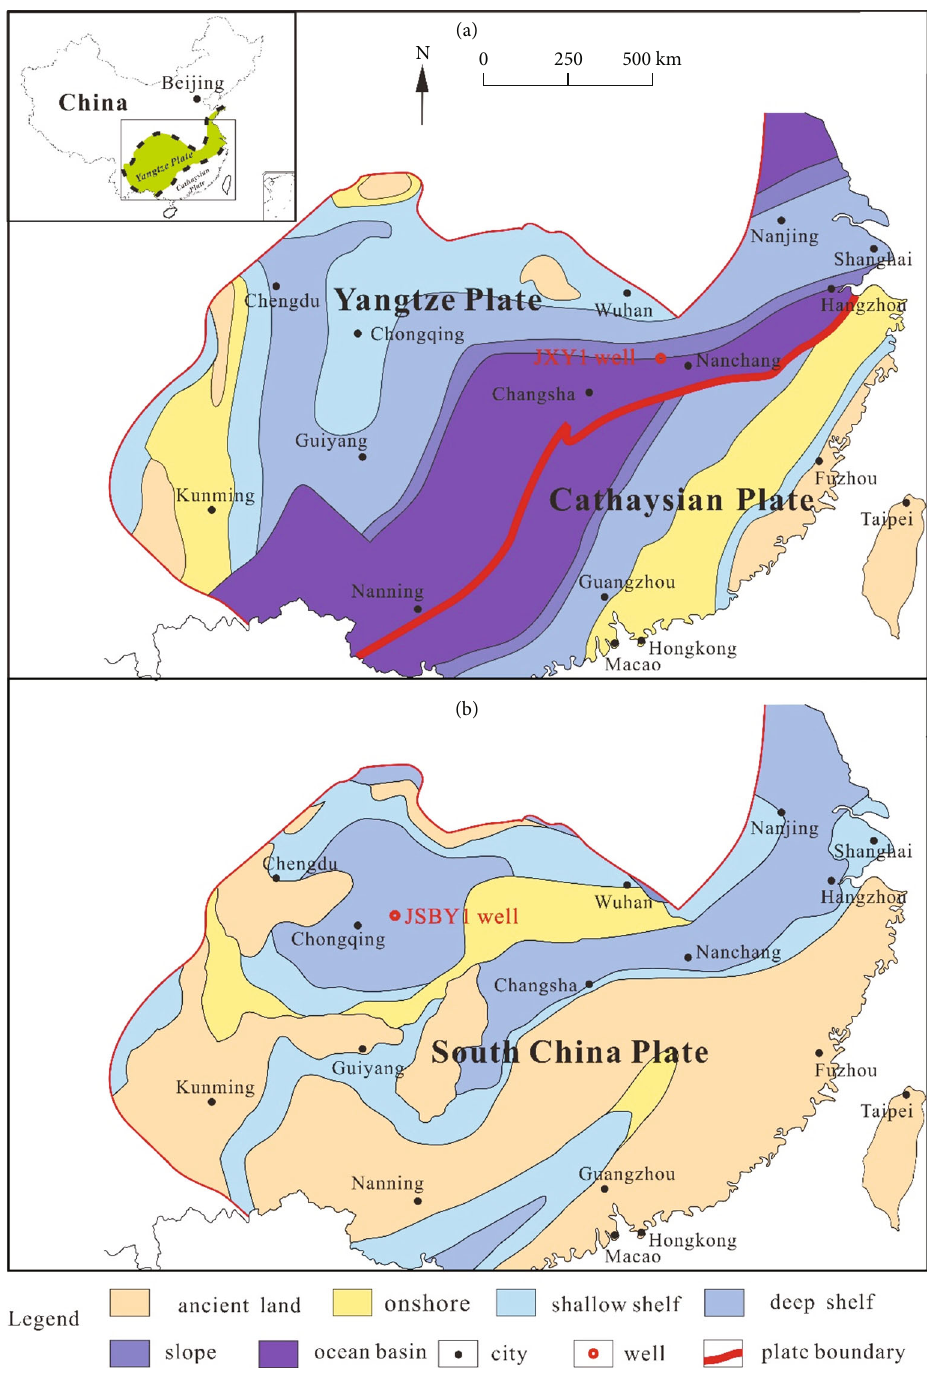
Figure 1: Sedimentary characteristics of South China in the lower Cambrian (a) and the upper Ordovician-lower Silurian (b). Modi fi ed from References [15 –